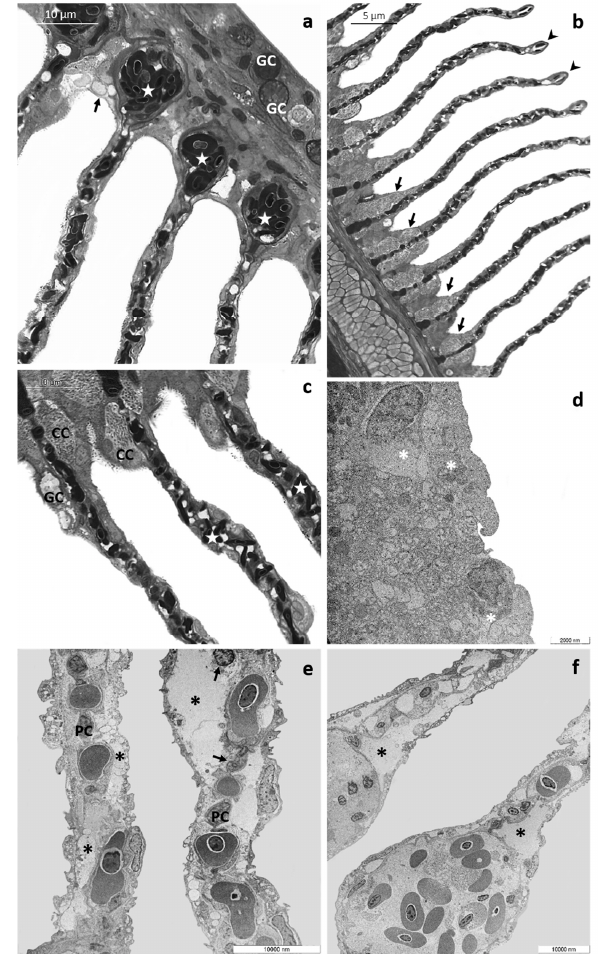
Figure 4. Representative micrographs of T. pavo gills after 96 h of exposure to 8 µg/L of CPF. ( a ) Light micrograph showing the flattened main filament and degenerated goblet cells (GC). Note numerous degenerating cells (black arrow) and aneurysms’ appearance in the vascular component (stars). ( b ) The main filament covers the proximal portion of lamellae, and chloride cells increase in number and volume (black arrows). Note also the aneurysms in the lamellar apical tips (black arrowheads). ( c ) Details showing goblet cells (GC) and chloride cells (CC) located in the medial and distal portion of the secondary lamellae; also note the disorganization of vascular component (stars). ( d ) TEM micrograph showing degenerating cells on the main filament (asterisks). ( e ) Secondary lamellae completely lose their typical arrangement, and large lacunae are visible (asterisks). Note the cellular debris (black arrows) and the degeneration of pillar cells (PC). ( f ) Detail of apical tips dilation of secondary lamellae (asterisks).